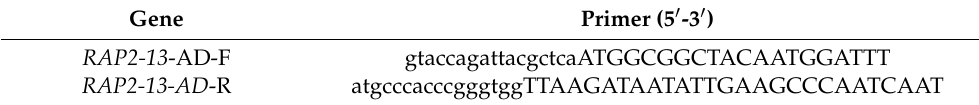
Table 5. Primer sets used in RAP2-13 cloning.